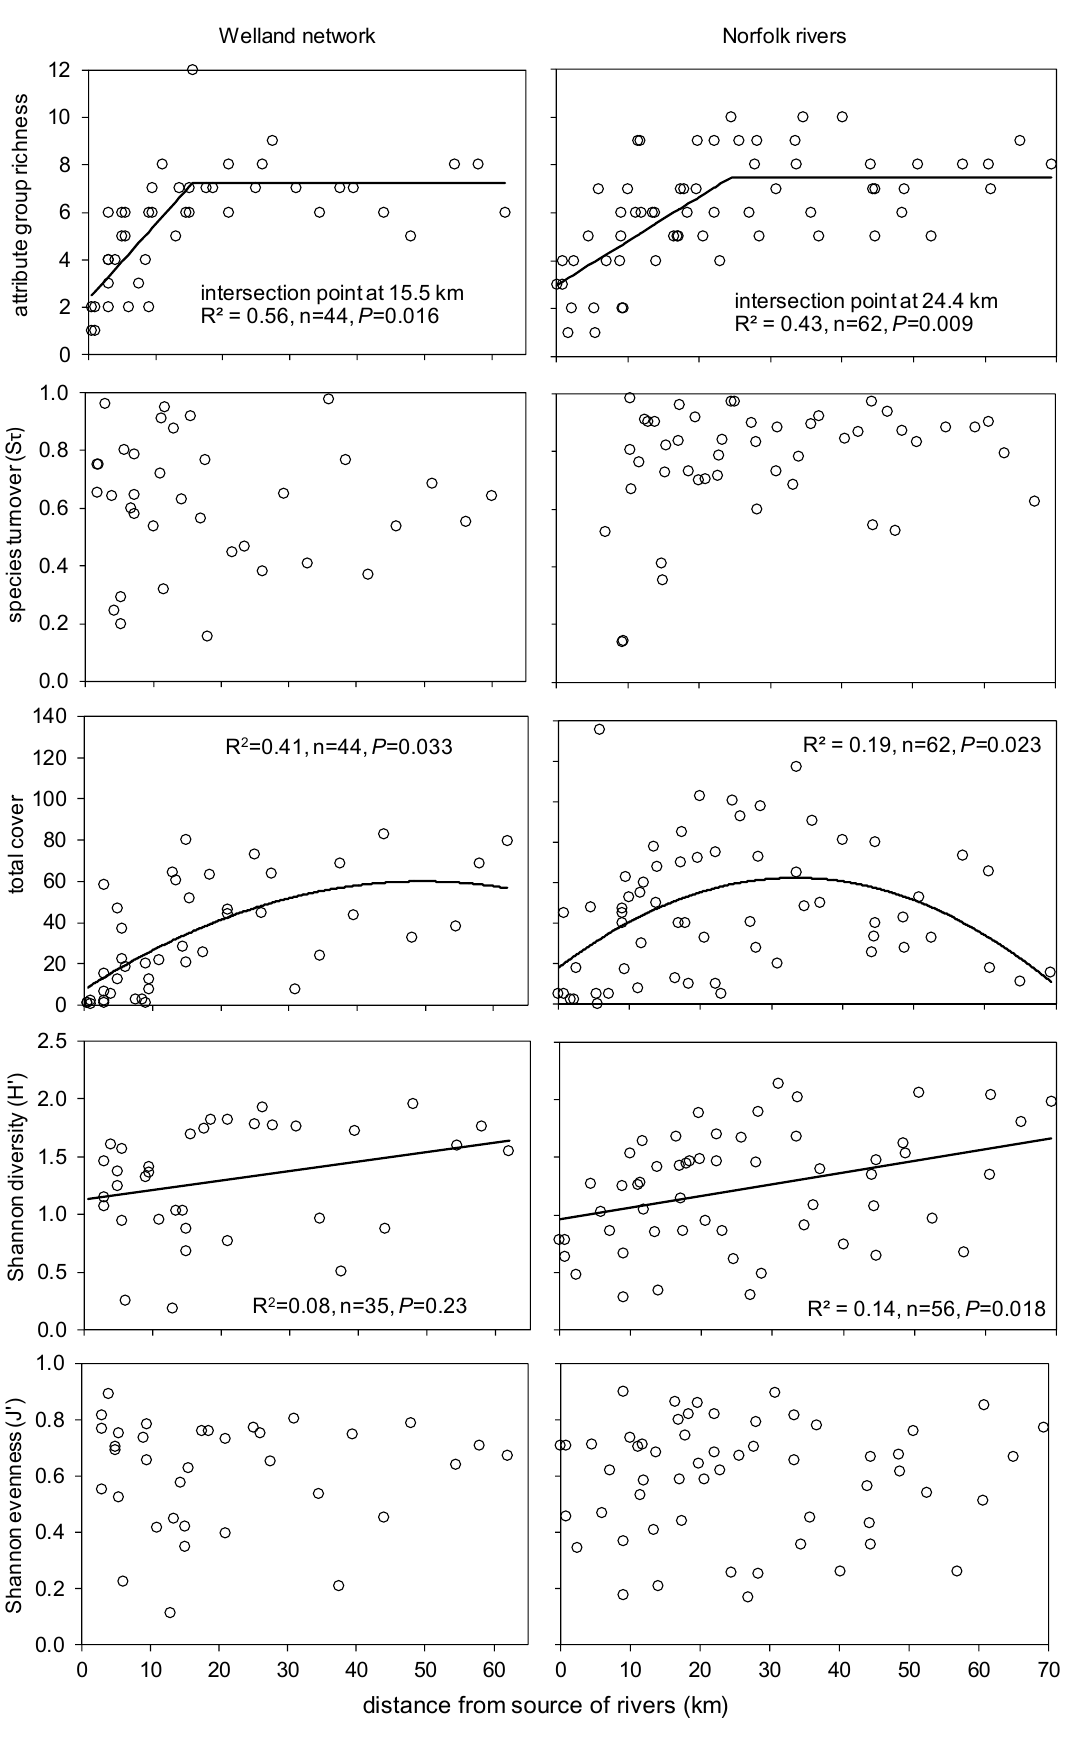
Figure 14. Changes in community structure against distance from